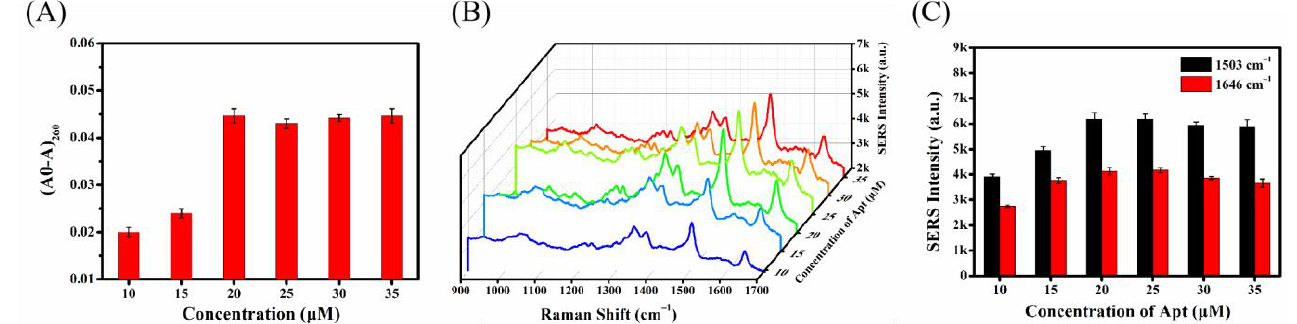
Figure 3. Results of optimizing the concentration of aptamer used to prepare the SERS probe. ( A ) Variations in UV-Vis absorption values of aptamer solutions at concentrations of 10 – 35 μM before (A0) and after (A) incubation with Au NPs. ( B ) SERS spectra of Au NPs modified with aptamers at concentrations of 10 – 35 μM. ( C ) Intensities of the characteristic SERS peaks of ROX at Raman shifts of 1503 cm −1 and 1646 cm −1